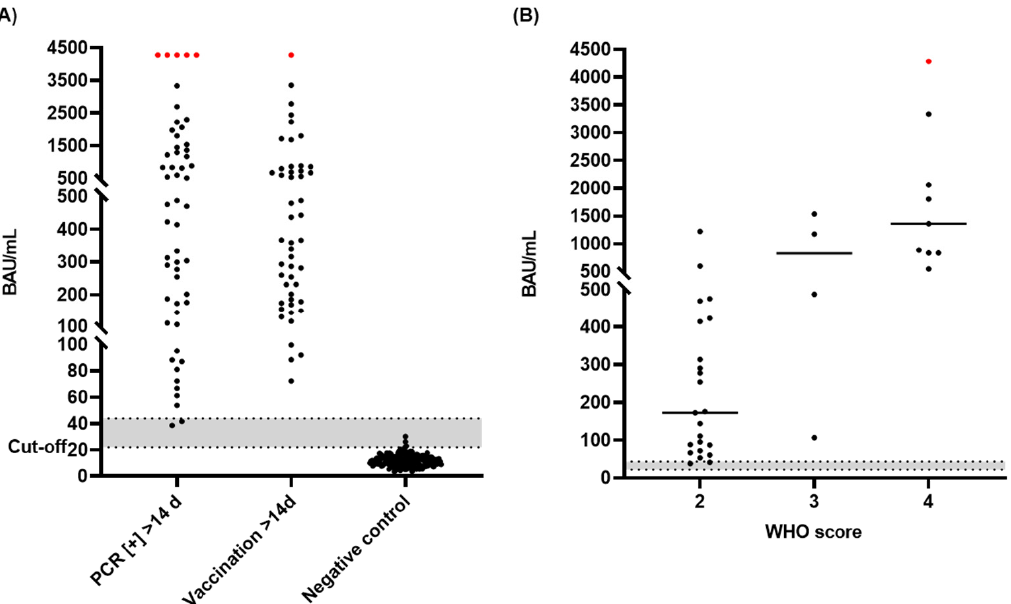
Figure 2. Anti-S antibody titers (BAU/mL) of samples from SARS-CoV-2-infected patients, COVID-19 vaccine recipients, and negative controls. ( A ) A total of 54 serum samples from persons infected with SARS-CoV-2 collected at least 14 days after a positive PCR-test, 58 samples collected from vaccinated donors 14 days or longer after first vaccine (Pfizer-BioNTech, Moderna, and AstraZeneca), and 173 serum samples collected before 2018. ( B ) Serum samples (36) collected from persons infected with SARS-CoV-2 (>14 days after positive PCR test) were grouped by severity of symptoms based on their WHO score (2 to 4). Results were converted to binding antibody units (BAU/mL) using the absorbances recorded at 450 nm of six calibrators. The highest positive (red) have a titer of >4280 BAU/mL because the analysis was performed up to this value. The cut-off was 22 BAU/mL for the in-house ELISA. The grey zone above the cut-off (22–44 BAU/mL) indicates a borderline range. Among the 54 infected patients, Klinikum St. Georg Leipzig provided 36